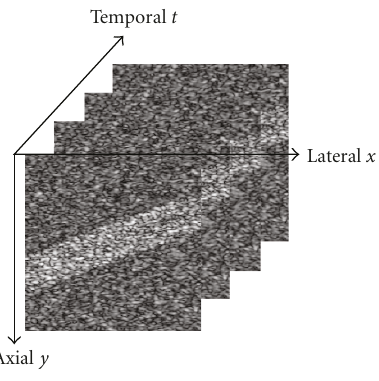
Figure 3: Stack of ultrasound